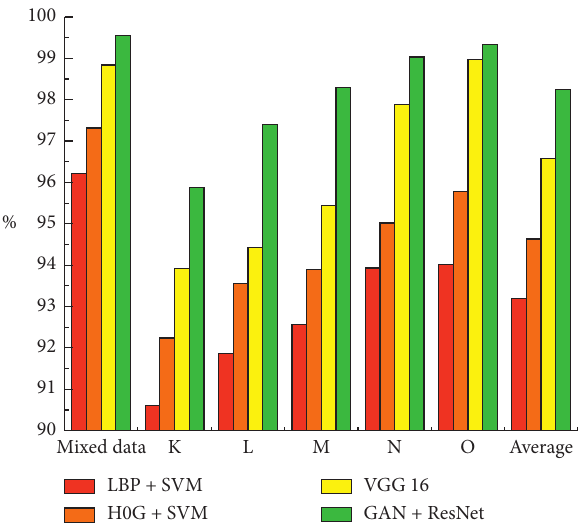
Figure 14: Accuracies of the different methods.